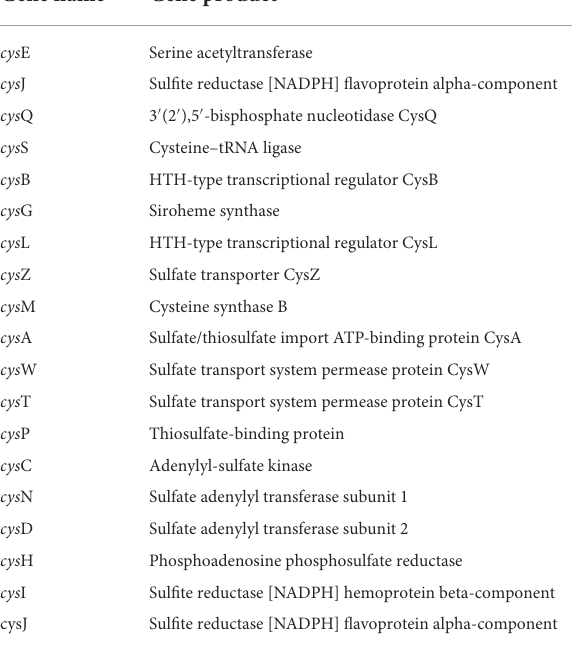
TABLE 3 P. agglomerans strain CPHN2 genomic annotation for sulfate